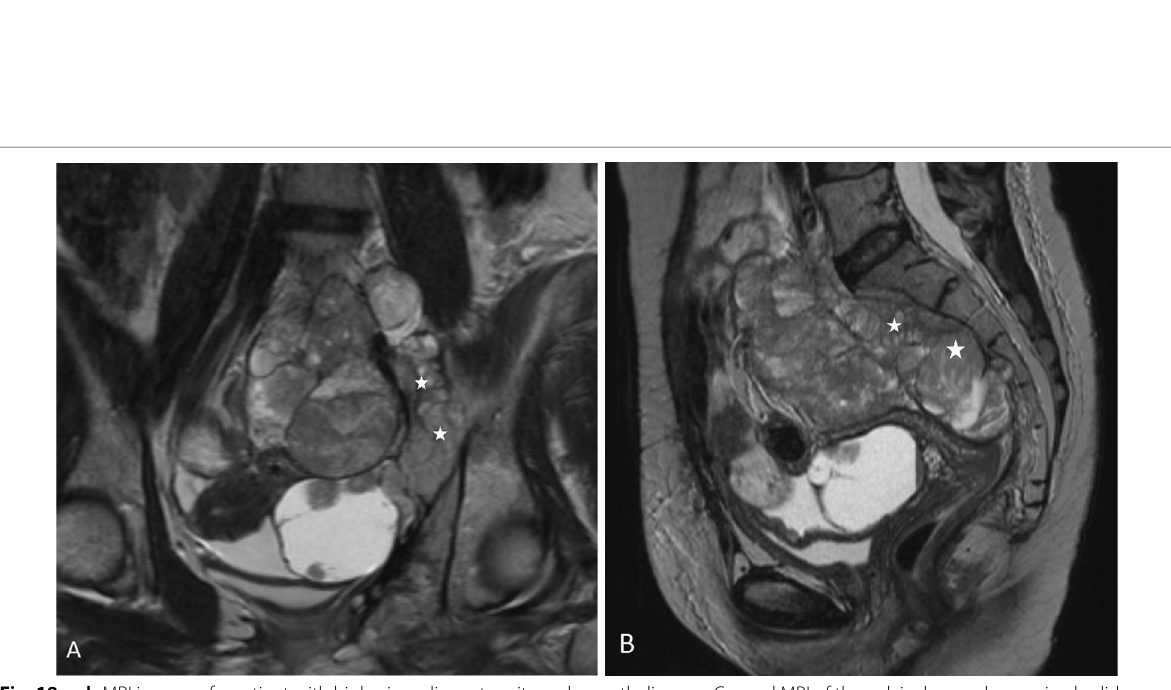
Fig. 18 a , b MRI images of a patient with biphasic malignant peritoneal mesothelioma. a Coronal MRI of the pelvis shows a large mixed solid cystic mass in the pelvis involving the left pelvic side wall (*). b Sagittal MRI of the pelvis shows the mass extending into presacral space (*). These constitute U2 findings which render complete cytoreduction